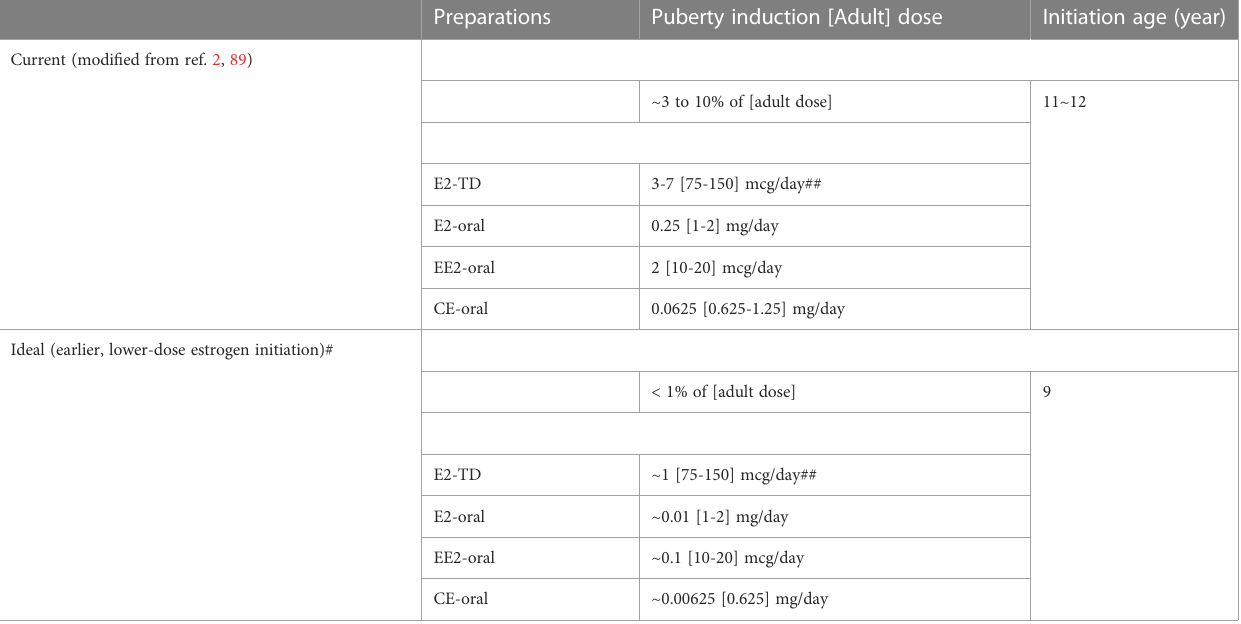
TABLE 6 Comparisons between current and ideal# pubertal induction using estrogen in TS without endogenous estrogen. Preparations Current (modi fi ed from ref. 2,